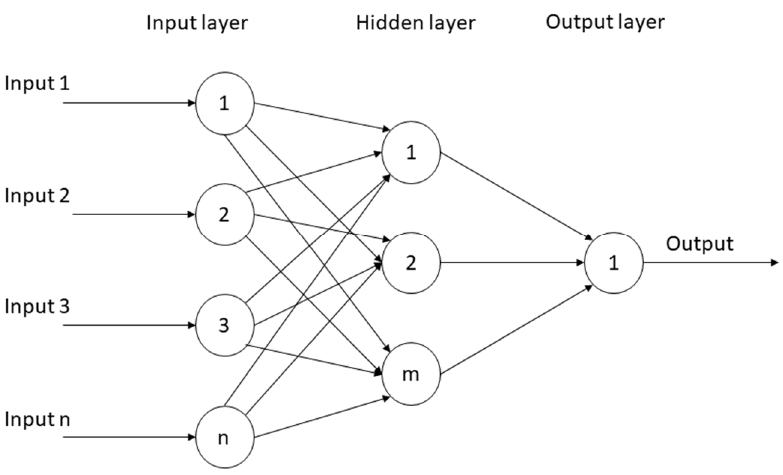
Figure A4. Scheme of an artificial neural network with three layers.